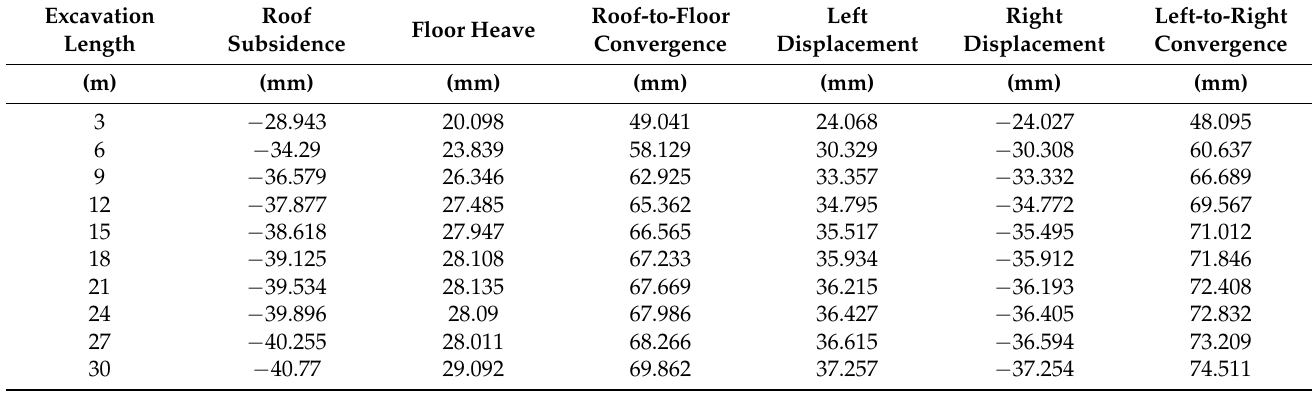
Table 2. Displacement of roadway surrounding rock with excavation depth without